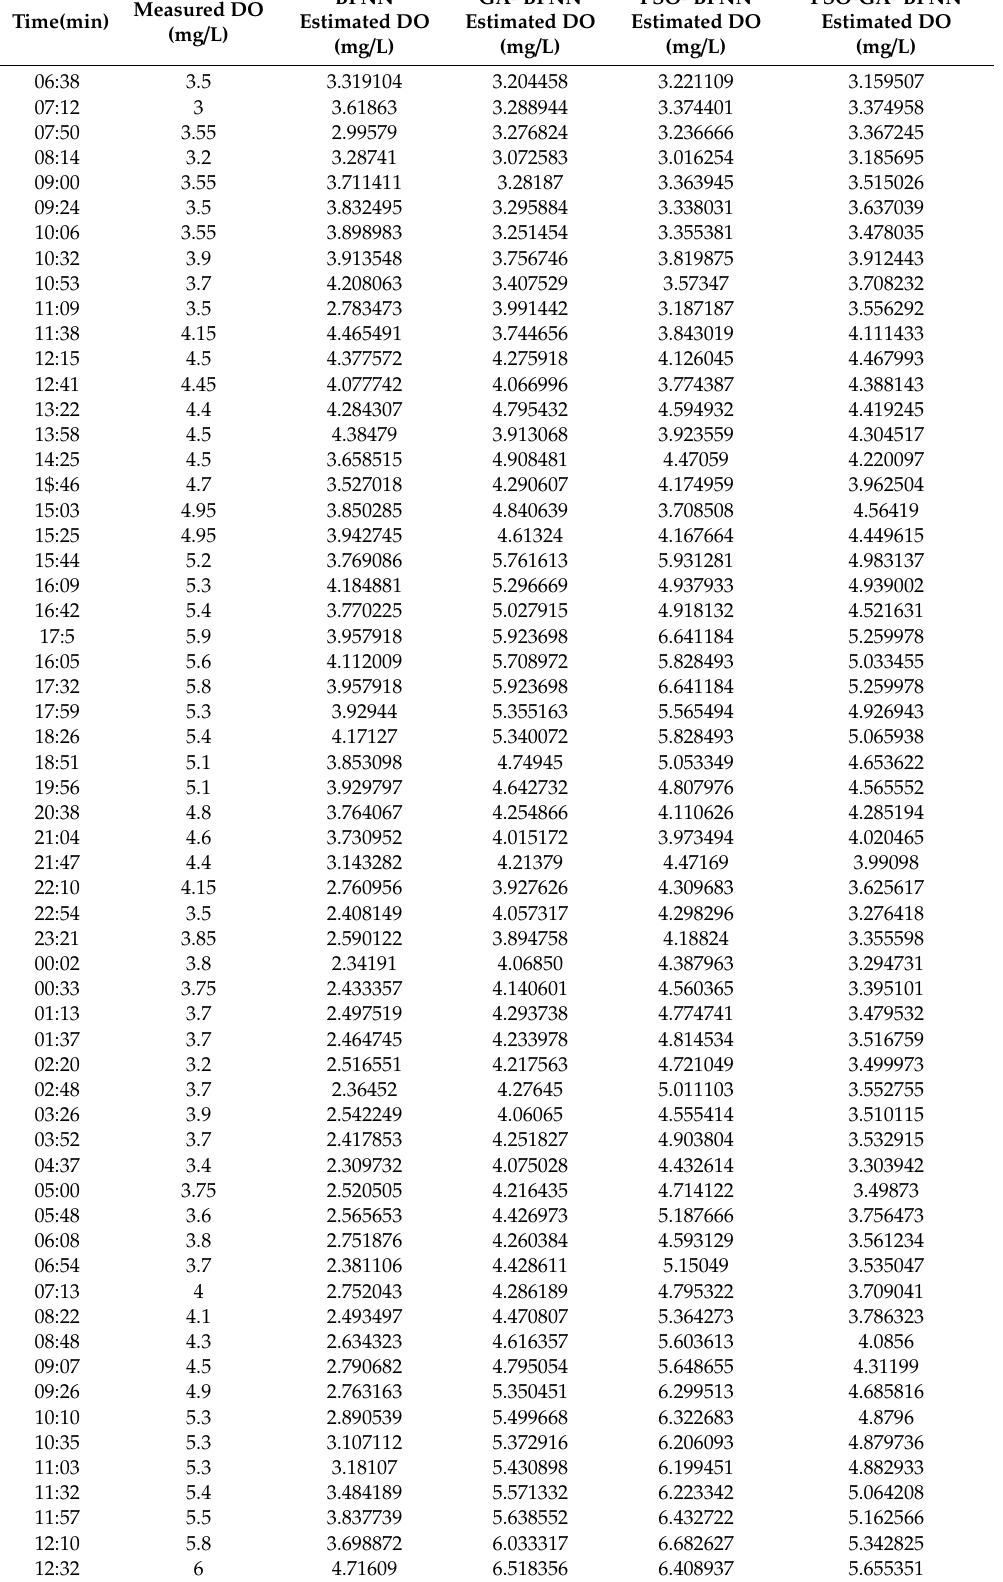
Table 2. Comparison of the measured value and the predicted value in time